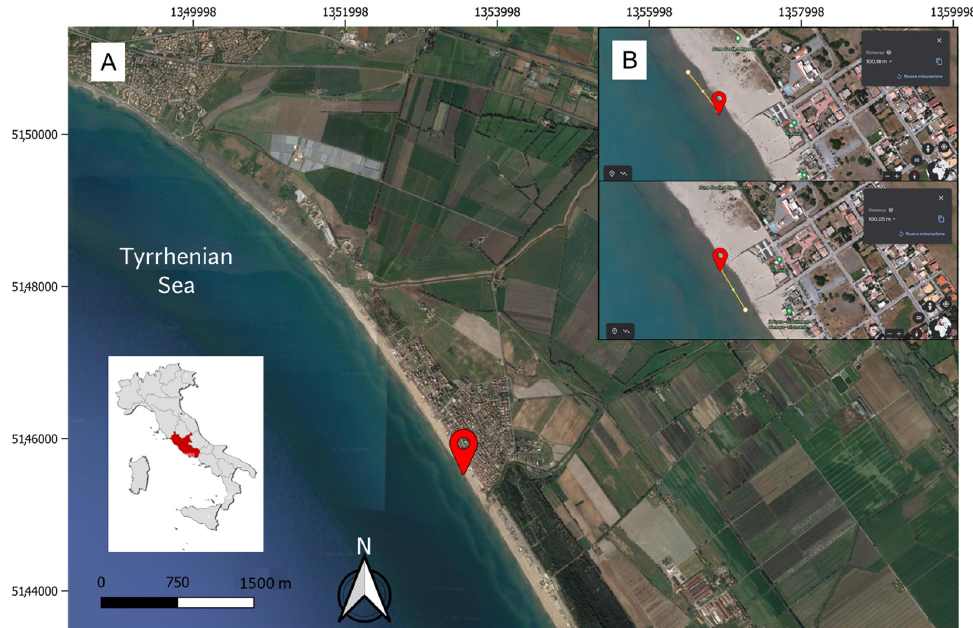
Figure 1. ( A ) Location of the sampling site along Passoscuro Beach on the Tyrrhenian Coast (Central Italy). In red, the position of Lazio Region on the Italy map. ( B ) Transects conducted to collect samples, 100 m north and 100 m south from the starting point.